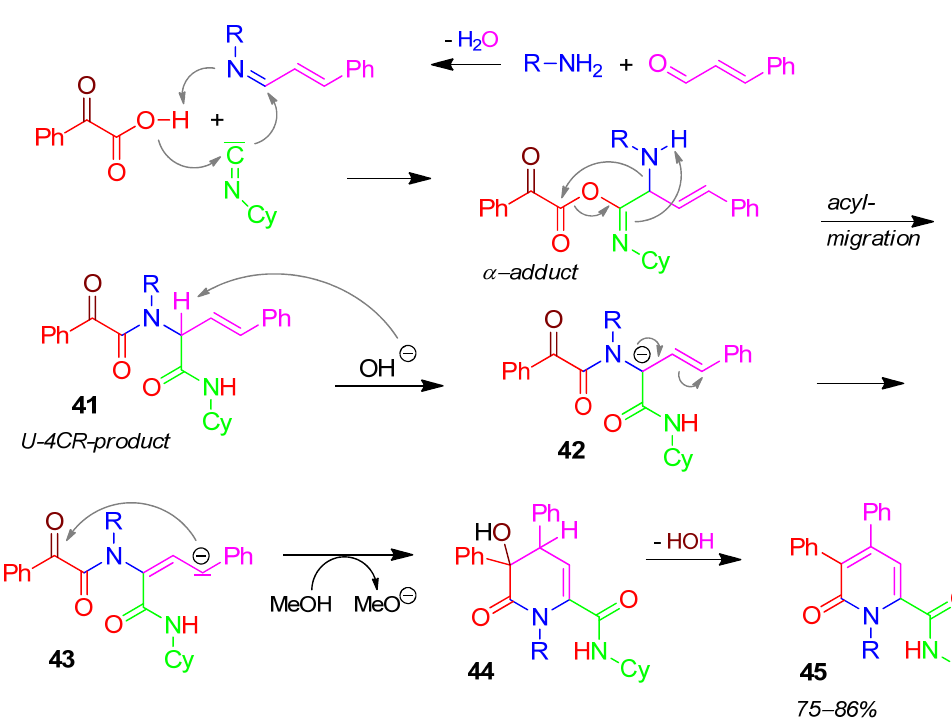
Scheme 20. Synthesis of pyridine 45 by